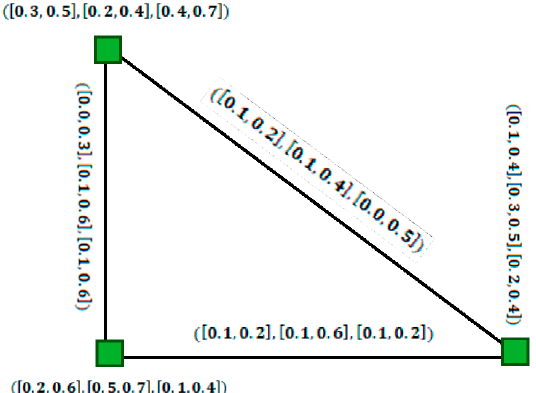
Figure 24. Complement of the graph depicted in Figure 23.